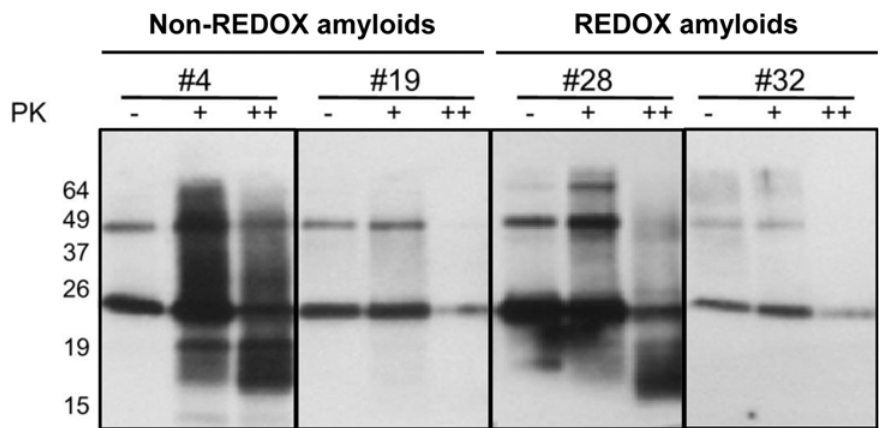
Fig 4. PK digestion assay of amyloid #4, #19, #28 and #32. Western blotting of PK digestion assay (amyloids #4, #19, #28, #32) showed partial protease K (PK) resistance of recMoPrP(23 – 231) (amyloids #4 and #28). RecMoPrP(23 – 231) amyloids (PK- lanes) were digested with PK at ratio 1:10 (w/w) (PK+ lanes) and 1:1 (w/w) (PK++ lanes). Western blots were performed using Fab D18 monoclonal antibody (1 μ g/mL). Blots were developed with the enhanced chemiluminescent system (ECL, Amersham Biosciences) and visualized on Hyperfilm (Amersham